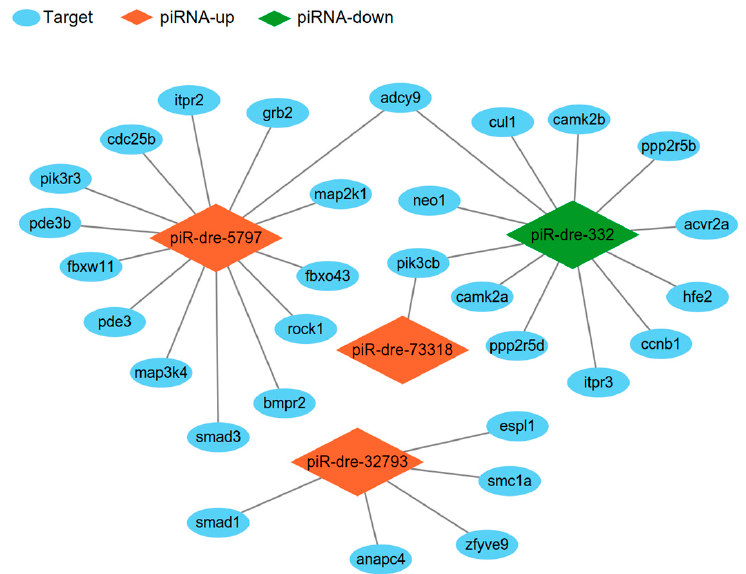
Figure 7. Piwi-interacting RNAs–target interaction network analysis. The orange rhombus represents up-regulated piwi-interacting RNAs in the male fish compared to levels in female fish, while the green rhombus represents down-regulated piwi-interacting RNAs in male fish. The blue ellipse represents target genes enriched in sex-related pathways.